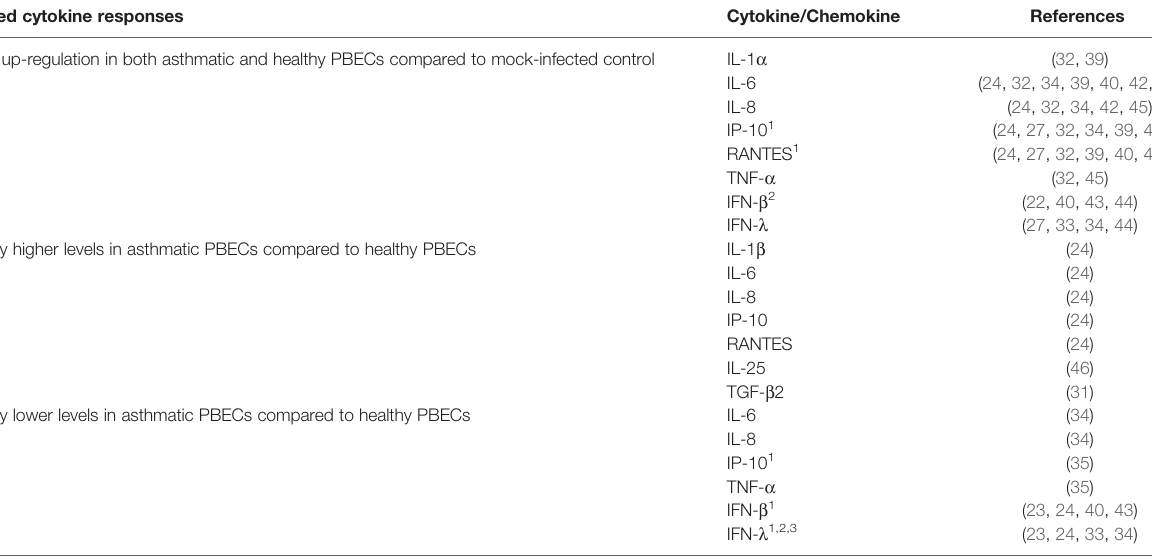
TABLE 1 | Findings of ex vivo PBECs studies comparing RV-induced cytokine responses in asthmatic vs healthy